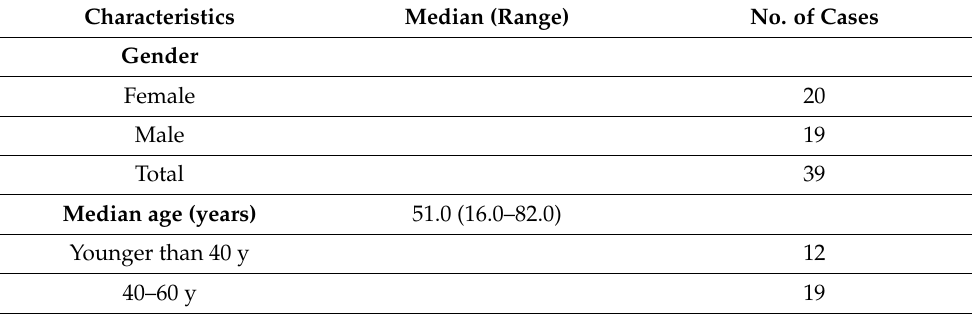
Table 1. Clinical characteristics of newly diagnosed AML